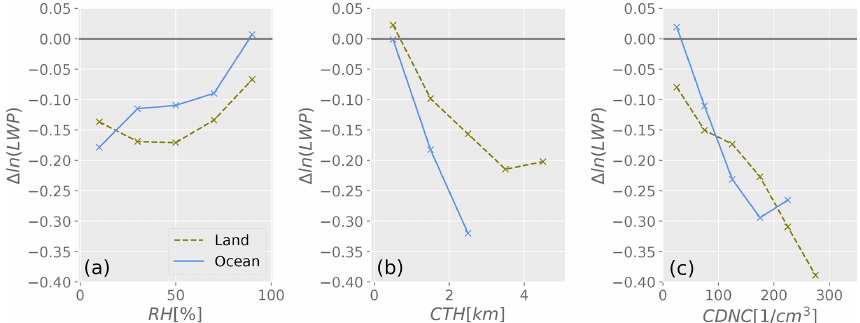
Figure 11. Cloud water response depends on the meteorological conditions. Dependence on above-cloud relative humidity (RH, a ), cloud top height (CTH, b ), and background cloud droplet number concentration ( N d , c ) is shown independently for ocean-based ship and volcano tracks (blue line represents data from Christensen and Stephens, 2012; Toll et al., 2017) and land-based industry and fire tracks (green line represents data from Toll et al.,